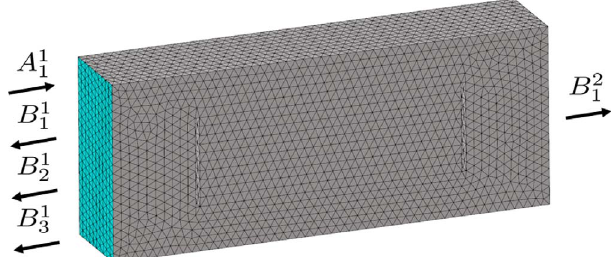
Figure 3. FEM model of baf fl e silencer housed in a rectangular duct.